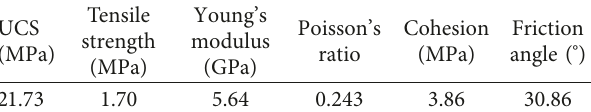
Figure 1: Geometrical parameters and joint arrangement. Table 1: Mechanics parameters of rock-like